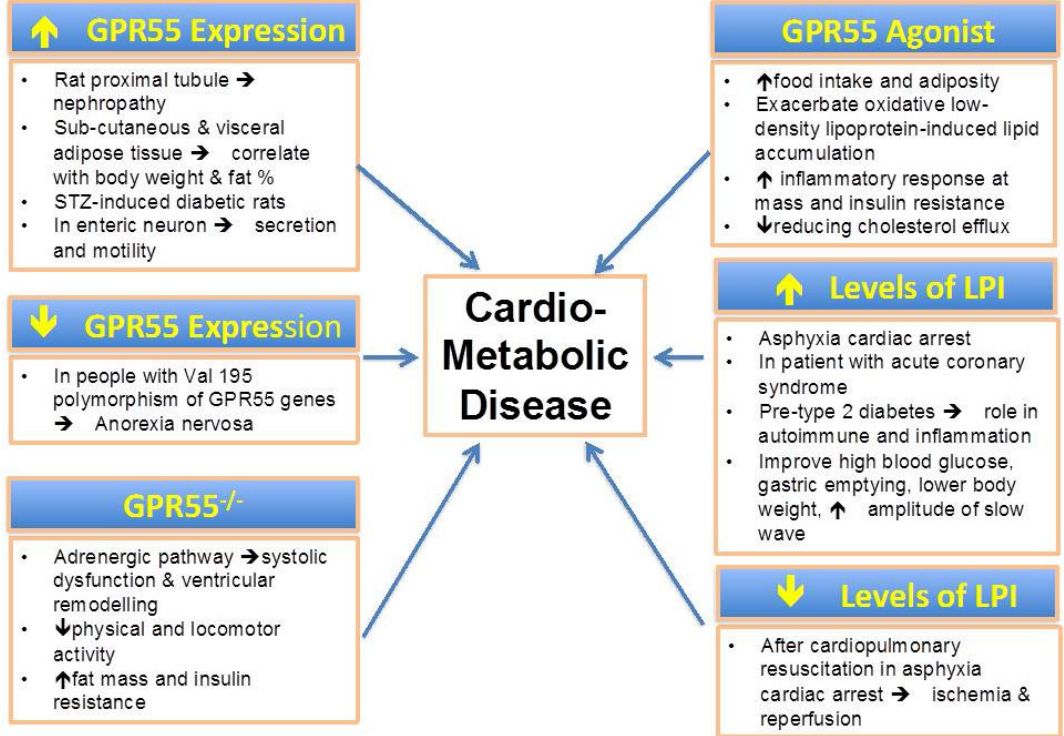
Figure 1. The pathophysiological relevance of GPR55 expression, levels of LPI and potential role of its agonist in cardio-metabolic diseases.